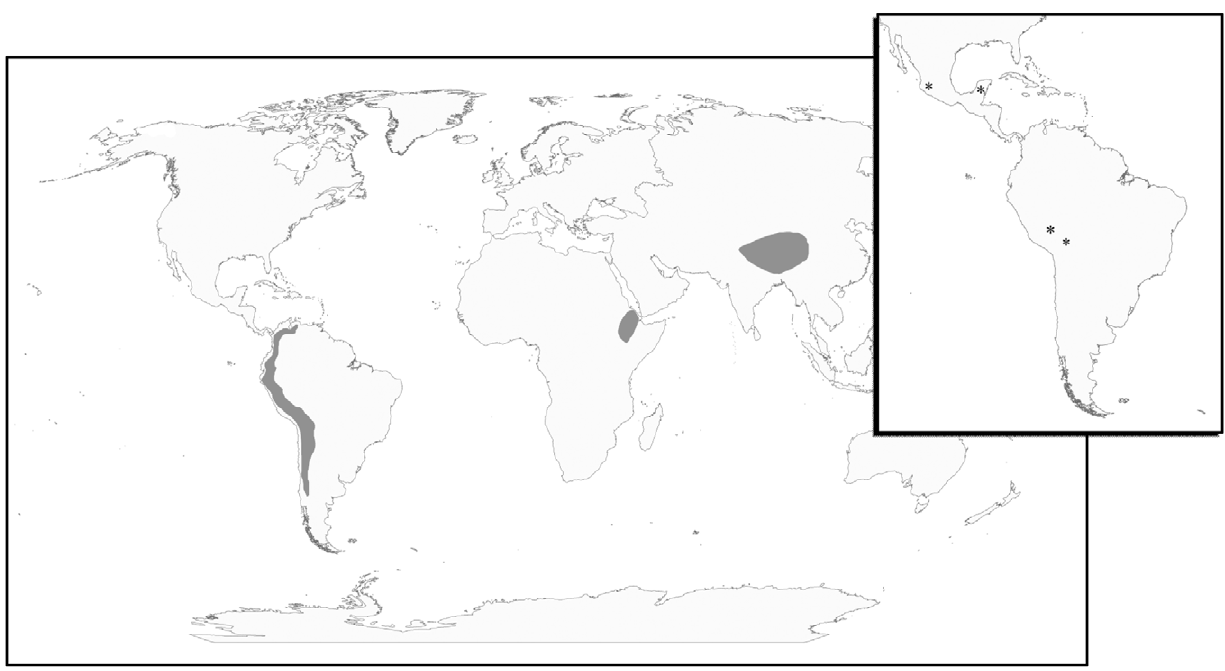
Figure 1. The geography of human adaptation to high altitude. Geographic locations where humans have adapted to life at high-altitude are indicated in grey and include the Andean Altiplano of South America, the Tibetan Plateau of Central Asia, and the Semien Plateau of Ethiopia. Only populations from the Andean Altiplano and the Tibetan Plateau were considered here. Inset: Map locations of the four Native American population samples including Peruvian Quechua, Bolivian Aymara, Nahua, Mixtec, and Tlapanec speakers from Guerrero, Mexico, and Maya from the Yucatan Peninsula, Mexico.